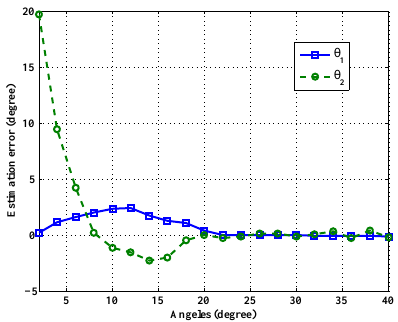
Figure 7. Comparison of DoA estimation error under different angle separations.